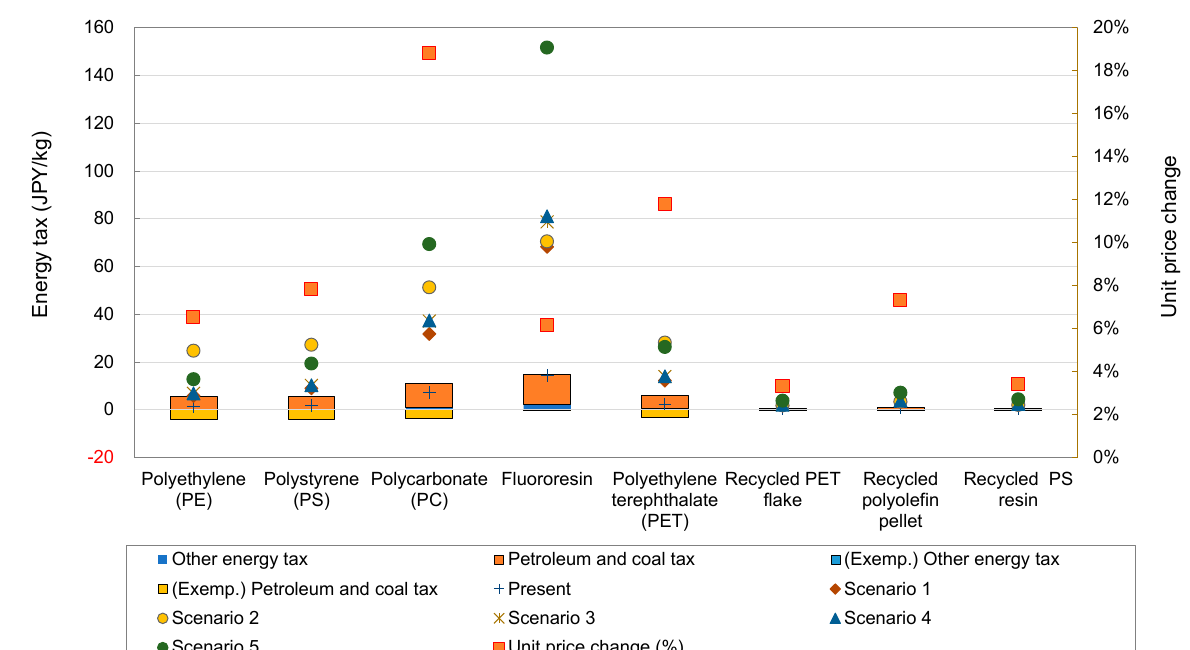
Figure 5. Changes in product taxes and product prices in chemicals under different taxation scenarios. The bar graphs show the present taxation breakdown. The percentage change in product prices compares the present with Scenario 5.